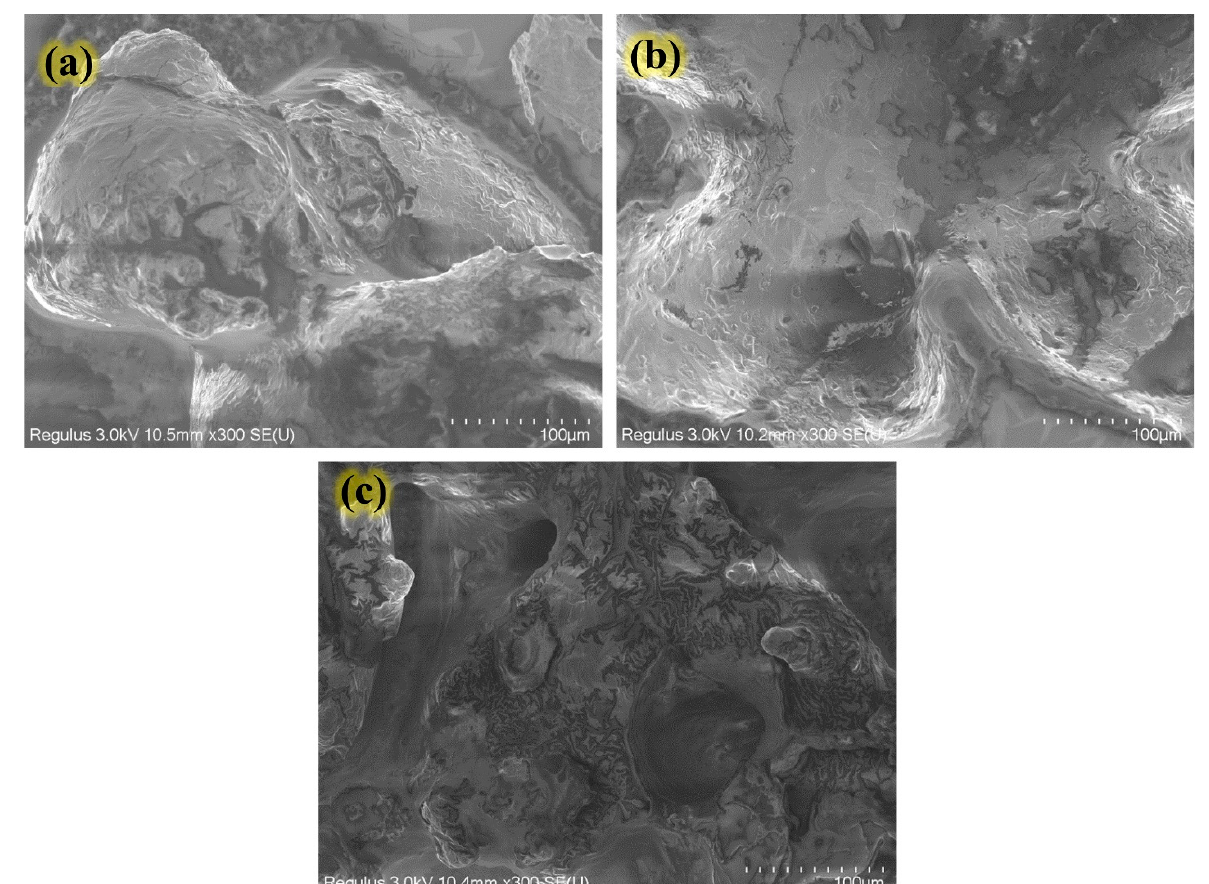
Figure 3. Scanning electron microscopy (SEM) of protein hydrolysates at various degrees of hydrolysis; ( a ) DH 16.56%, ( b ) DH 22.23%, and ( c ) DH